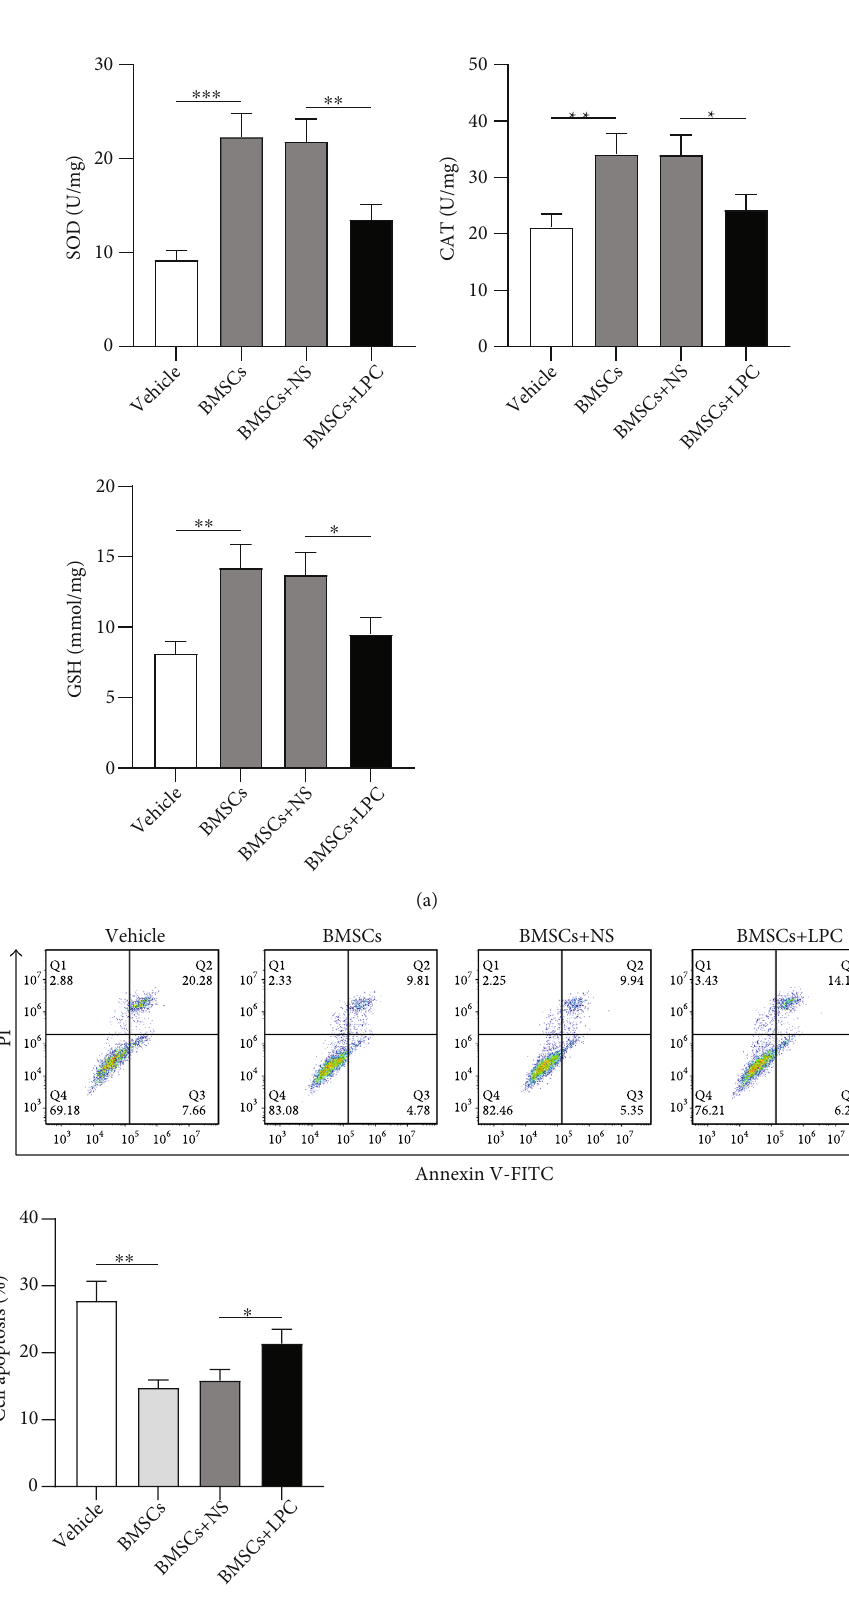
Figure 5: LPC o ff sets the protective e ff ects of BMSCs on oxidative stress injury of HRMECs. (a) The activities of CAT and SOD and the content of GSH in BMSC-cocultured HRMECs after LPC treatment were subjected to ELISA. (b) BMSC-cocultured endothelial cell apoptosis after LPC treatment was examined by fl ow cytometry analysis. ∗ p < 0 : 05 , ∗∗ p < 0 : 01 , and ∗∗∗ p < 0 : 001